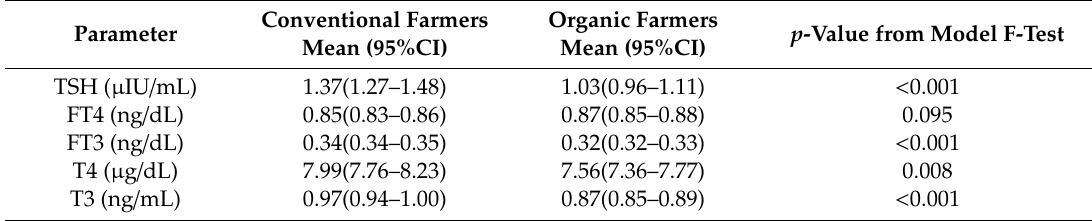
Table 2. Estimated Marginal Geometric Mean * of Thyroid hormones for four rounds of measurement for conventional and organic farmers.